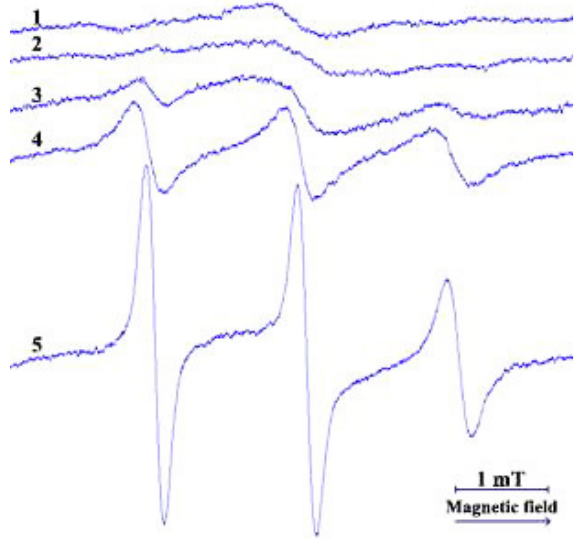
Fig. 8. EPR spectra of probe 2 in water (1) and aqueous solutions of M20CE at concentrations: 2 – 0.005 %;